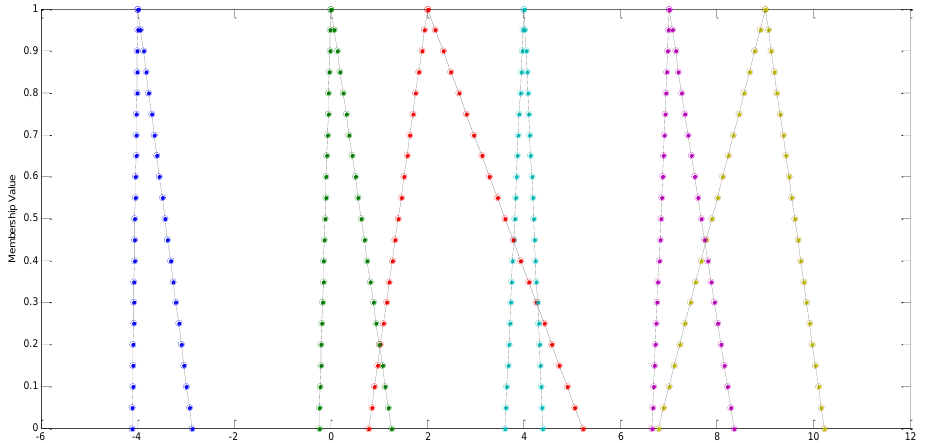
Figure 2. The Hausdorff distance of solutions with 𝜀 = 10 −3 in the Gauss–Seidel method is 0.4335 × 10 −4 .